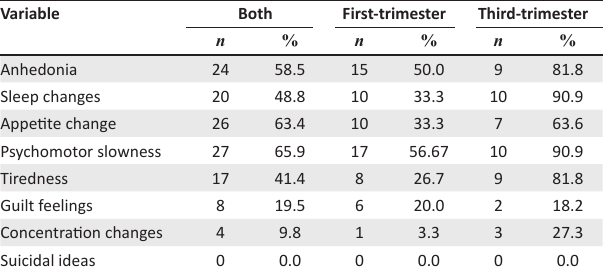
TABLE 6: Table showing the frequency of the items of depressive